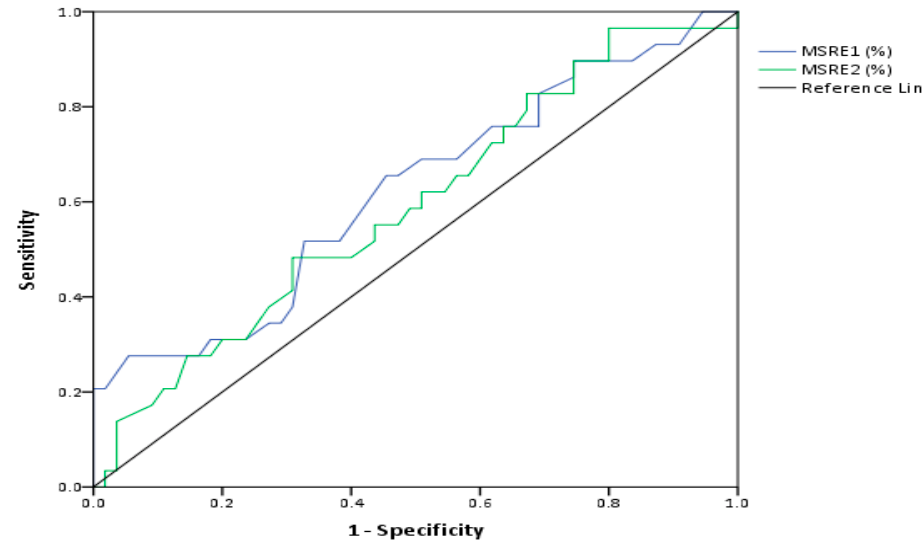
Figure 4. Evaluation of the efficacy of D4Z4 methylation status as a marker for classifying diseased and non-diseased individuals. The receiver operating characteristic (ROC) curve was plotted to analyze the values of methylation at D4Z4 as a discriminator between affected and unaffected individuals . Table 3. The area under the curve (AUC) threshold of the model.